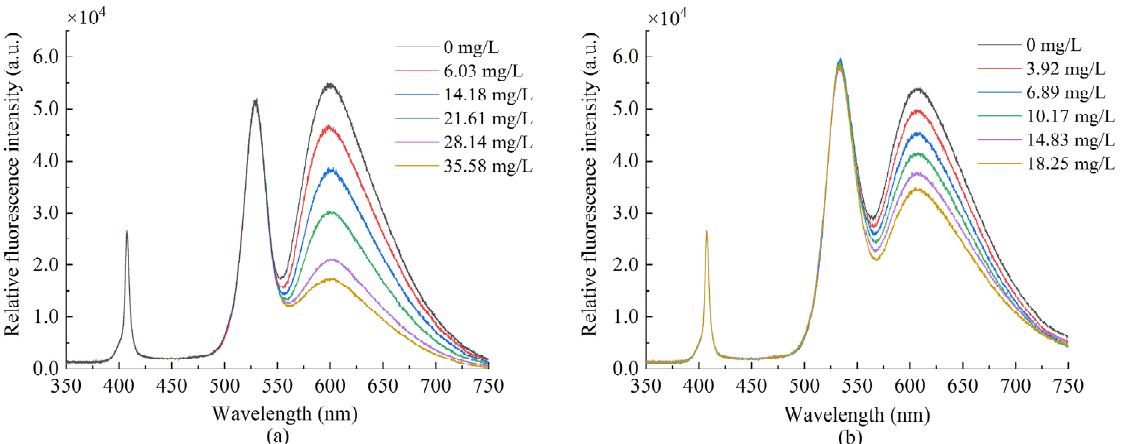
Figure 6. Fluorescence emission spectra of sensor prepared with composite dyes in ( a ) gaseous oxygen ( b ) aqueous solution.